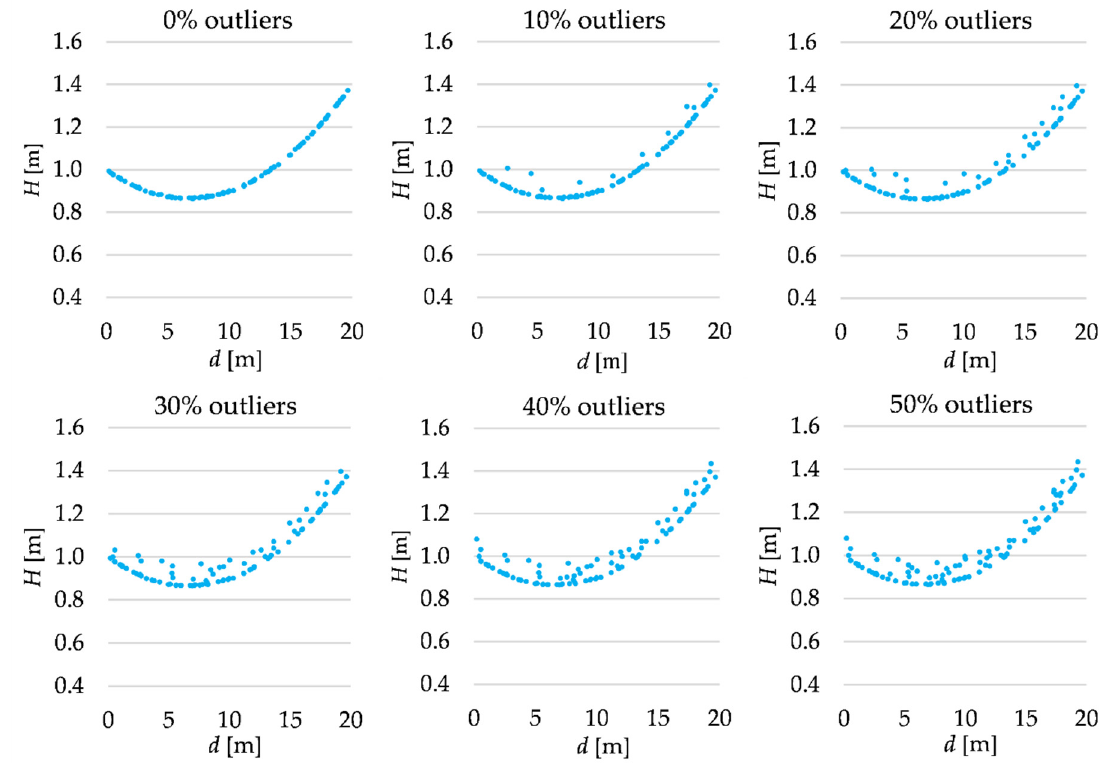
Figure 1. Simulated observation set (the second-degree polynomial).